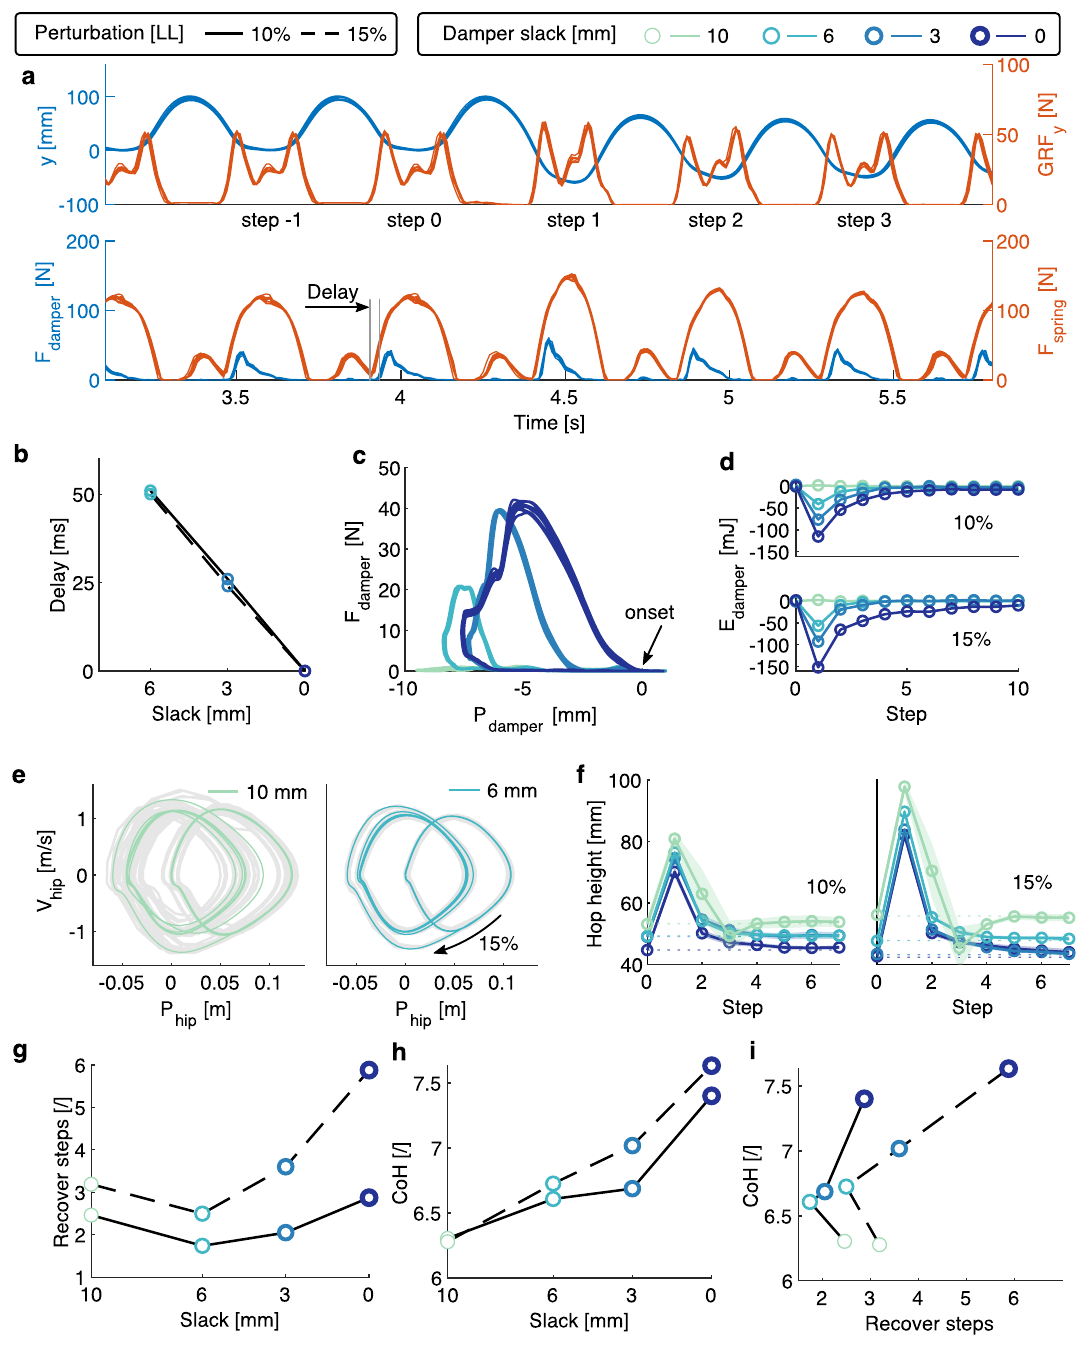
Figure 2. Vertical hopping with step-down perturbation: ( a ) 10-repetition-overlay time-series of hip position y , GRF, spring, and damper forces. 15% LL perturbation at step 1 increases the GRF, spring and damper forces due to higher impact speed. The damper starts to produce force with a delay to touchdown due to the 3 mm slack setting. ( b ) This damper engagement delay is adjustable by the damper slack setting. ( c ) The 10-repetition- overlay damper work loop in unperturbed periodic steps shows that the onset position can be reliably tuned and the standby dissipated energy (enclosed area) adjustable. ( d ) The average extra damper dissipated energy during perturbation steps. ( e ) Phase plot of hip position with 10 mm and 6 mm damper slack under 15% LL perturbation. The grey overlay shows the overlap of 10 repetitions of 20 steps, while the darker line is the averaged trajectory. ( f ) The average hopping apex height during perturbation steps. The transparent overlay represents the 95% confidence boundary. ( g ) The relationship between the number of steps to recovery after perturbation and the damper slack settings. ( h ) The relationship between the cost of hopping and the damper slack settings. ( i ) The relationship between the number of steps to recovery to the cost of hopping under different damper slack settings and perturbation